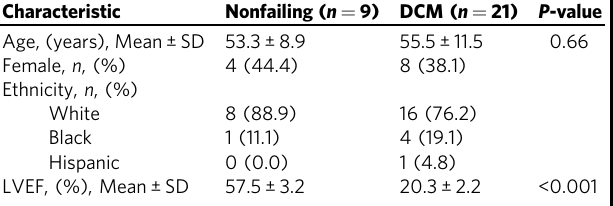
Table 1 Clinical characteristics of the human heart tissue